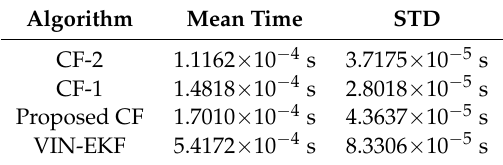
Table 3. Mean and standard deviation of time consumption of various algorithms.